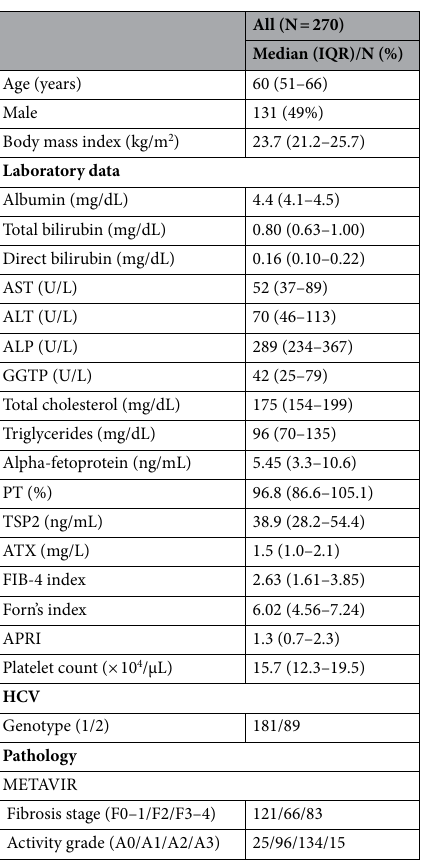
Table 1. Clinicopathological features of HCV-infected patients in the discovery cohort. ALT alanine aminotransferase, ALP alkaline phosphatase, APRI aspartate aminotransferase to platelet ratio